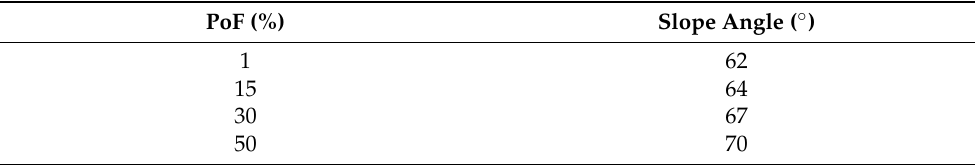
Table 5. Dip angle values of the rockface necessary to obtain PoF equal to 1, 15, 30, and 50%, respectively, according to the Q-slope method